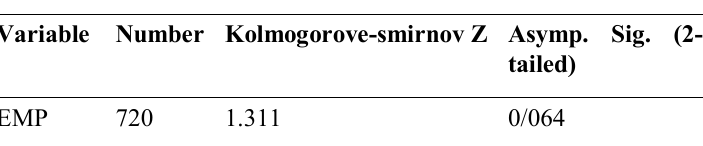
Table 3-The model`s dependent variable